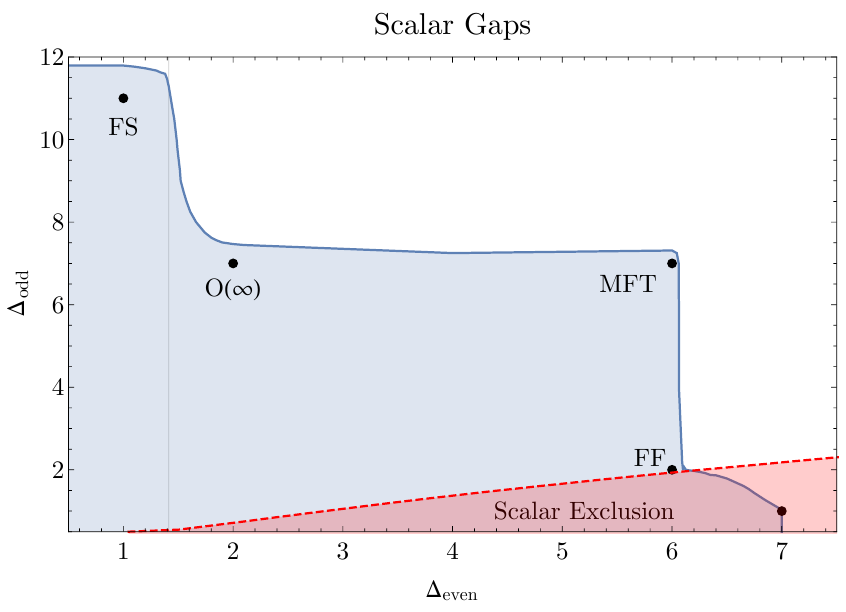
Figure 8 . Bound on the allowed gaps in parity-even and parity-odd scalar sectors (imposed si- multaneously). The blue shaded region is allowed by the h TTTT i bootstrap. The vertical grey line indicates the scaling dimension of (cid:15) in the Ising model. The red region is excluded from the scalar bootstrap for 4-point functions hO odd O odd O odd O odd i assuming O even appears in both the O odd (cid:2) O odd and T (cid:2) T